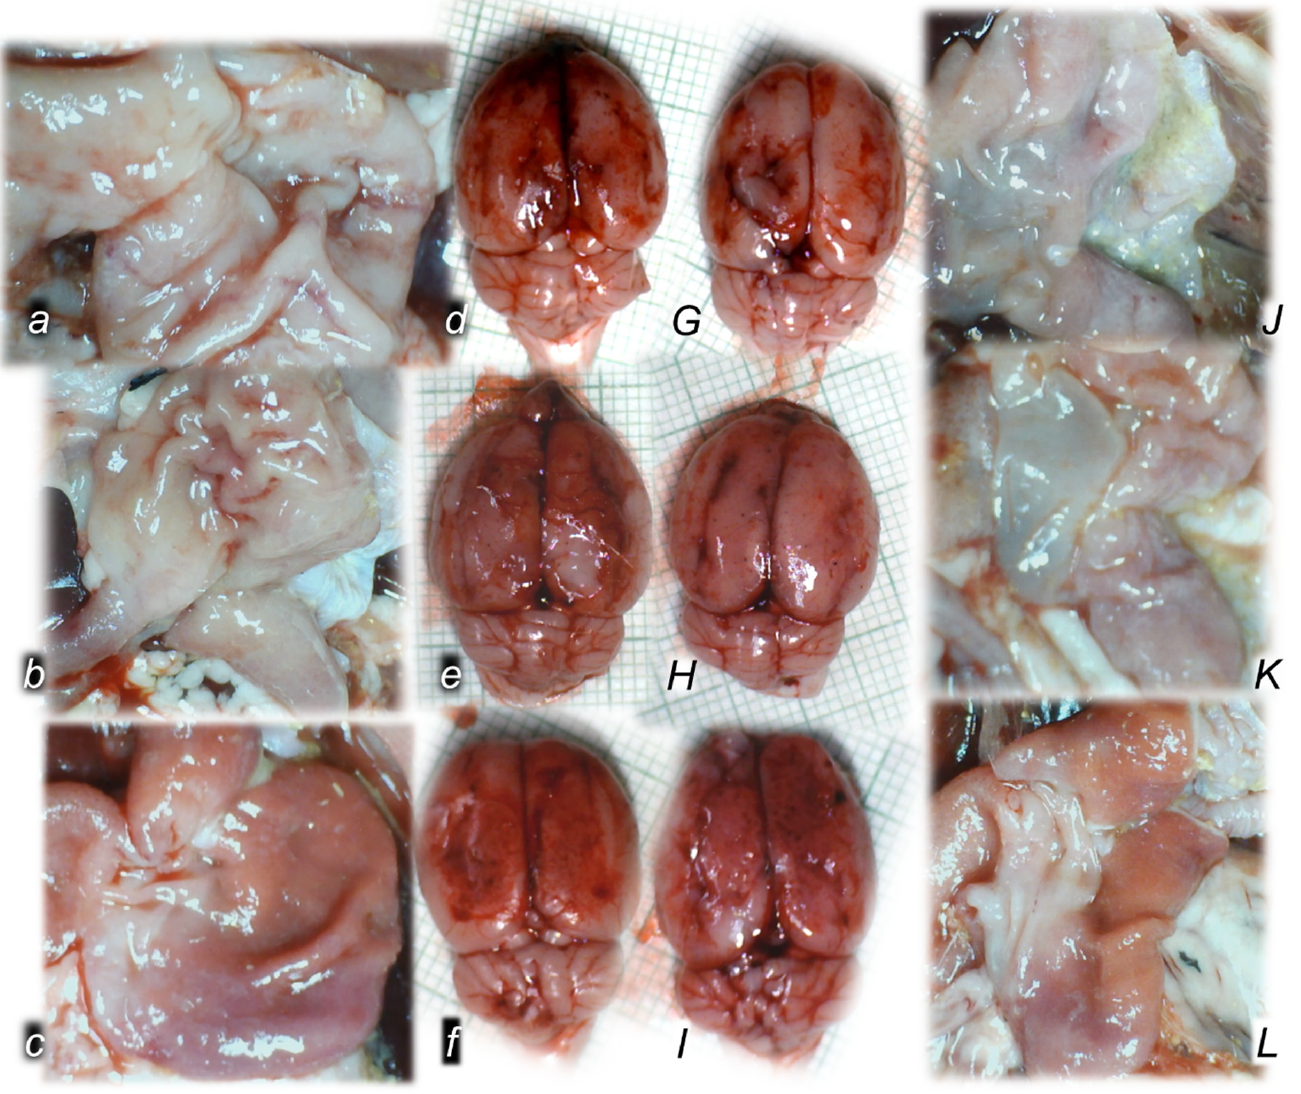
Figure 4. Stomach lesions and swollen brain in rats with occluded bile duct. Regular timeline (30 min ( a , d ), 5 h ( b , e ) and 24 h ( c , f ) ligation time period) of the stomach lesions’ presentation ( a – c ) and swollen brain ( d – f ) in controls. Upon BPC 157 therapy and recruitment of the defensive pathways, brain swelling (0–30 min ( G ), 0–5 h ( H ), 0–24 h ( I ) application sacrifice period) and gastric lesions (0–30 min ( J ), 0–5 h ( K ), 0–24 h ( L ) application sacrifice period) were counteracted. Illustrative presentation included BPC 157 (10 ng/kg) or saline (5 mL/kg) as an intragastric administration immediately following ligation, as an early regimen. A similar presentation also included the effect of the delayed regimen.